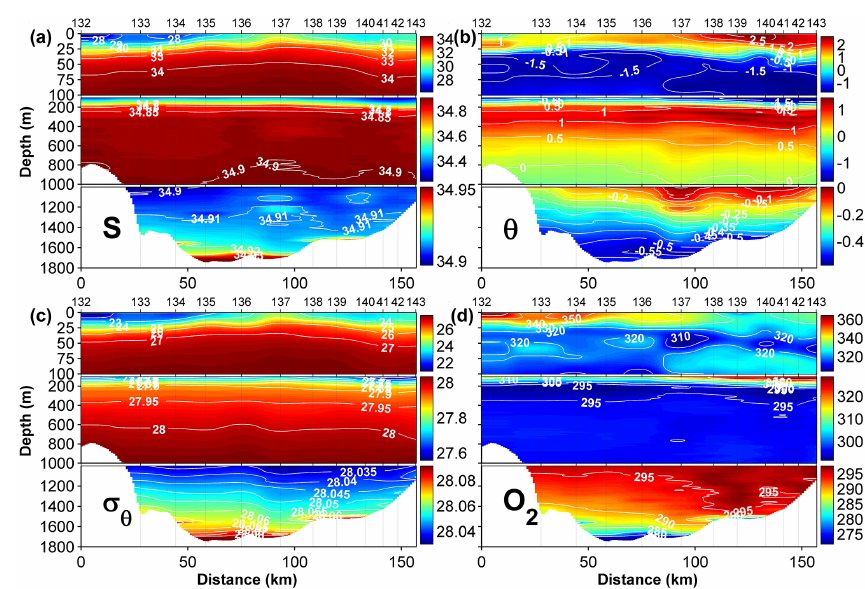
Figure 3. Sections across the southern passage showing (a) salinity S (psu), (b) potential temperature θ ( ◦ C), (c) potential density σ θ (kgm − 3 ) and (d) dissolved oxygen O 2 (µmolkg − 1 ). Please note the different color scales for the separate depth intervals. Note also that stations 141 and 142 are labeled as 41 and 42 in order to save space.